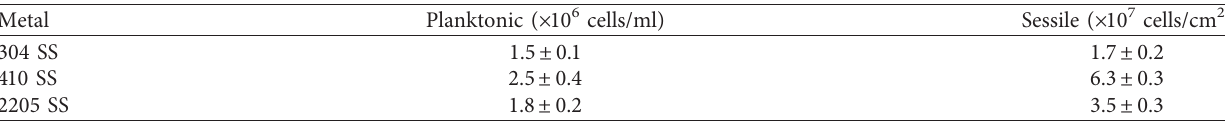
Figure 1: Three-electrode electrochemical glass cells at day 0 (a) and at the end of 7-day incubation (b). Note: the left wire was for the counterelectrode and the right wire for the working electrode. The center glass tube was for the reference electrode. Table 2: SRB cell counts after 7-day incubation.